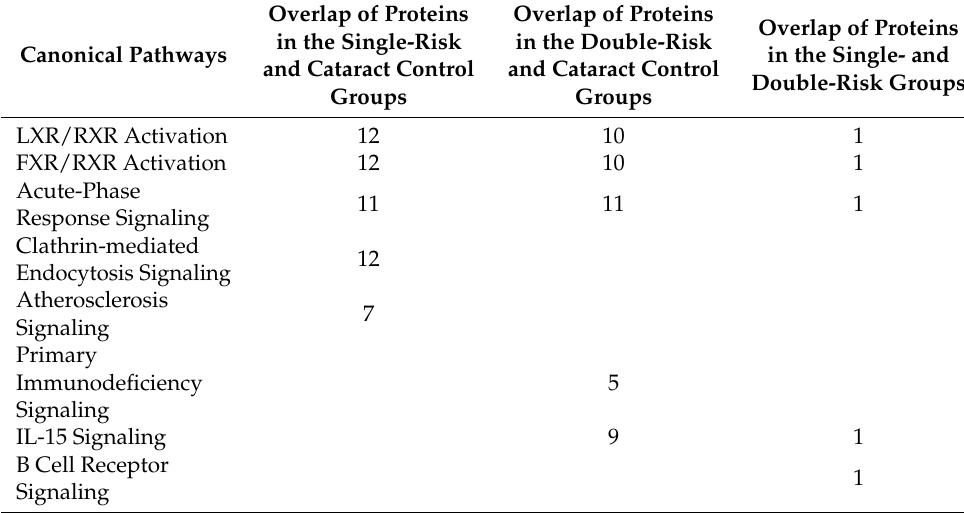
Table 3. Pathway analysis of aqueous humor (AH) proteins using IPA tools.